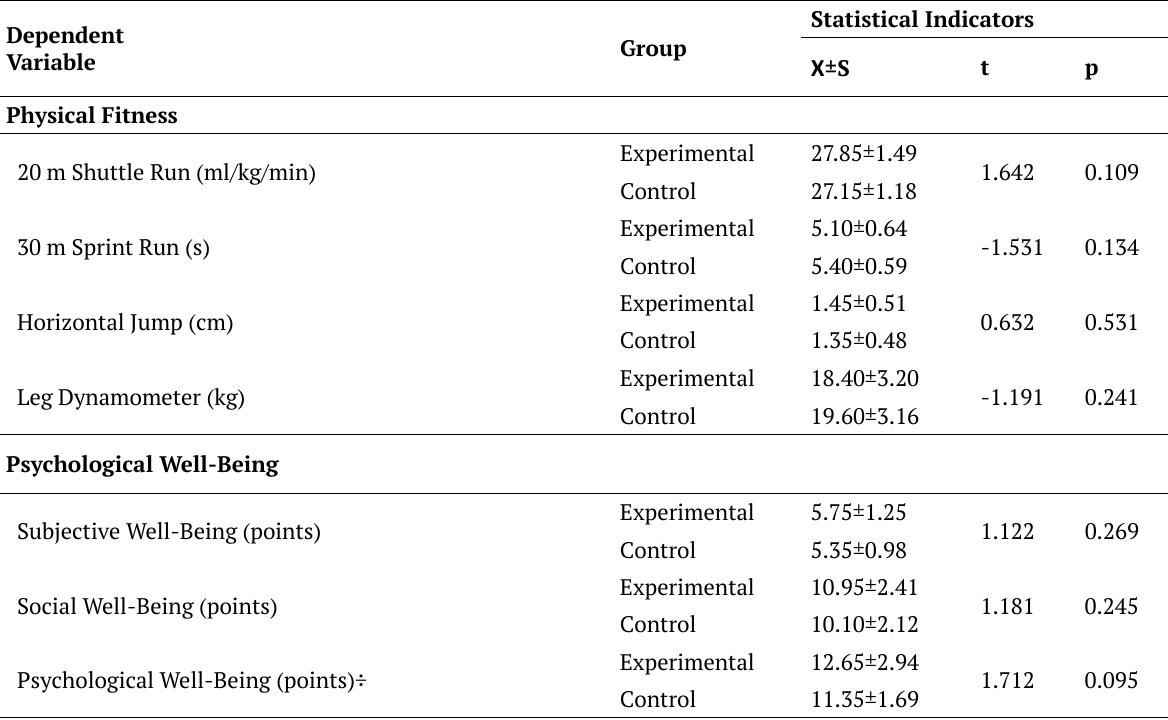
Table 4. The results of differences physical fitness and psychological well-being on the experimental (n=20) and control (n=20) groups before the experiment